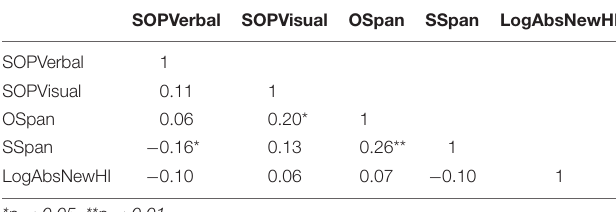
TABLE 3 | Correlation Matrix of SOPVerbal, SOPVisual, OSpan, SSpan, and LogAbsNewHI for All Participants. SOPVerbal SOPVisual OSpan SSpan LogAbsNewHI